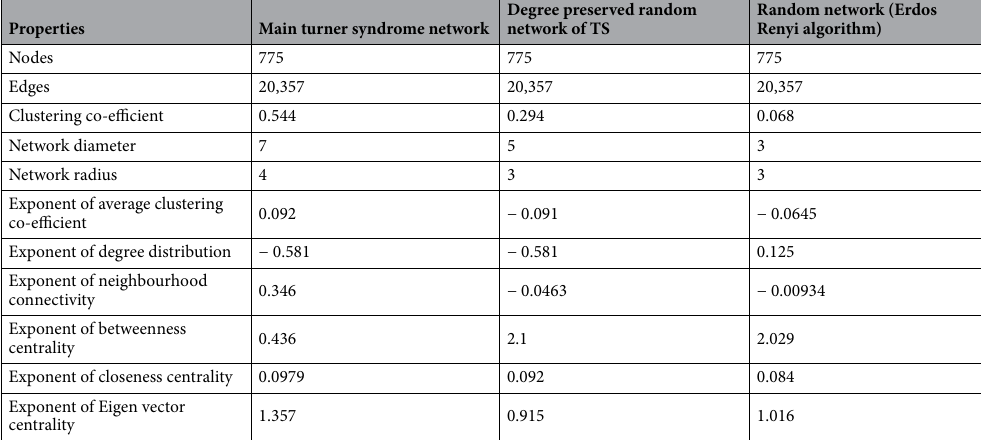
Table 5. Comparative analysis of TS PPI network with random networks of the same